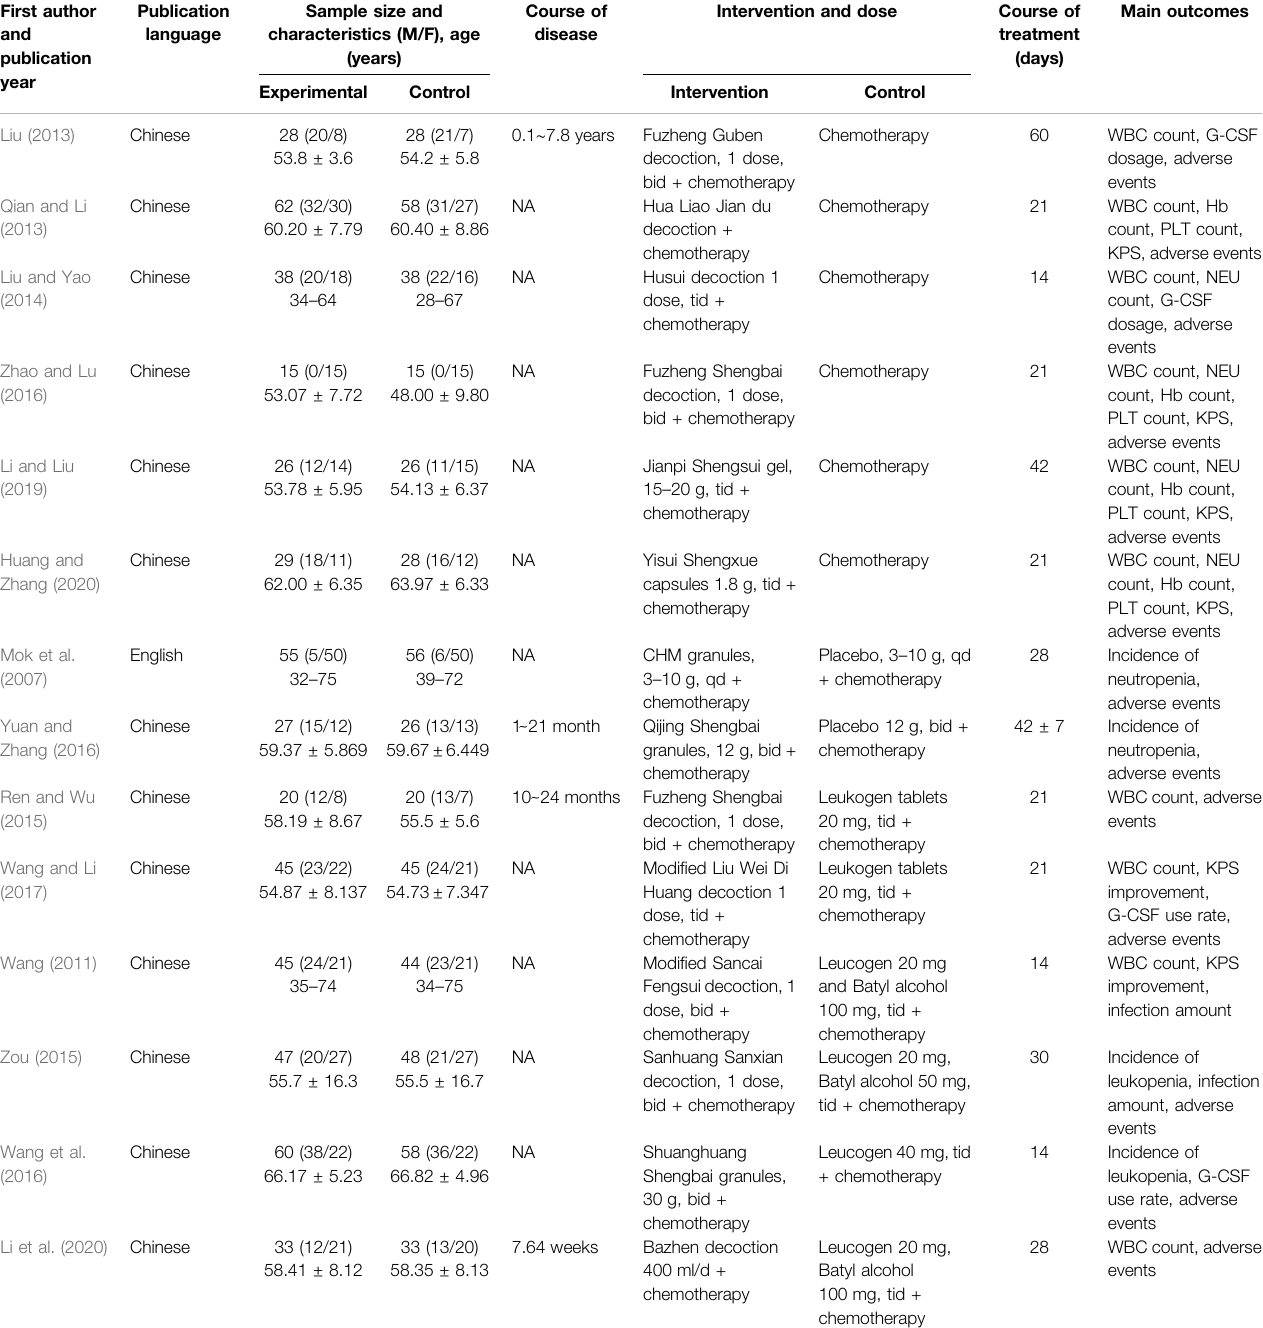
TABLE 1 | Characteristics of the included